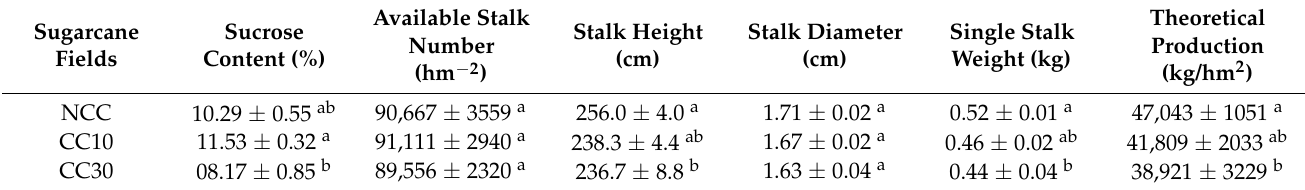
Table 1. Sugarcane plant agronomic characteristics, sugar content, and theoretical production. Sugarcane